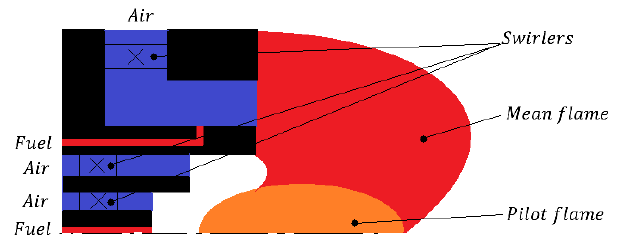
Fig. 4. TAPS combustor scheme (basing on [8])